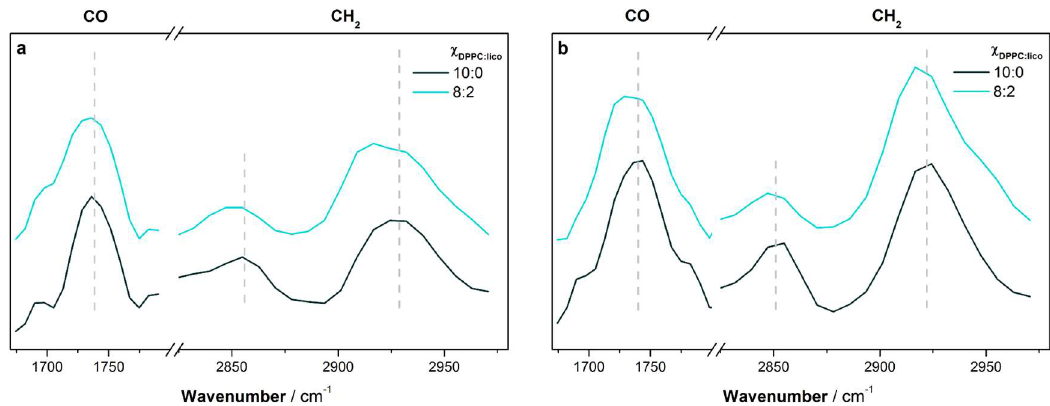
Figure 4. Polarization–modulation infrared reflection–absorption spectroscopy (PM-IRRAS) spectra in the molecular vibration frequency of the carbonyl (CO) and the methylene (CH 2 ) groups of the DPPC monolayer at pH 7.4 in the absence (X DPPC:lico 10:0) and in the presence of licofelone (X DPPC:lico 8:2) at ( a ) 10 mN m − 1 and ( b ) 30 mN m − 1 . Dashed lines are guides to the eye.